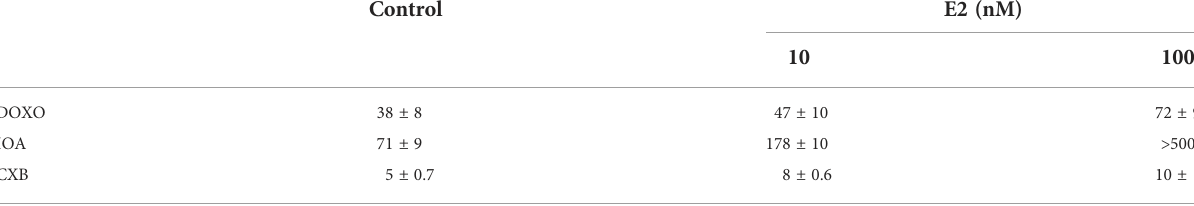
TABLE 1 IC 50 values (nM) of metabolic and canonical drugs for MCF-7 MCTS growth.